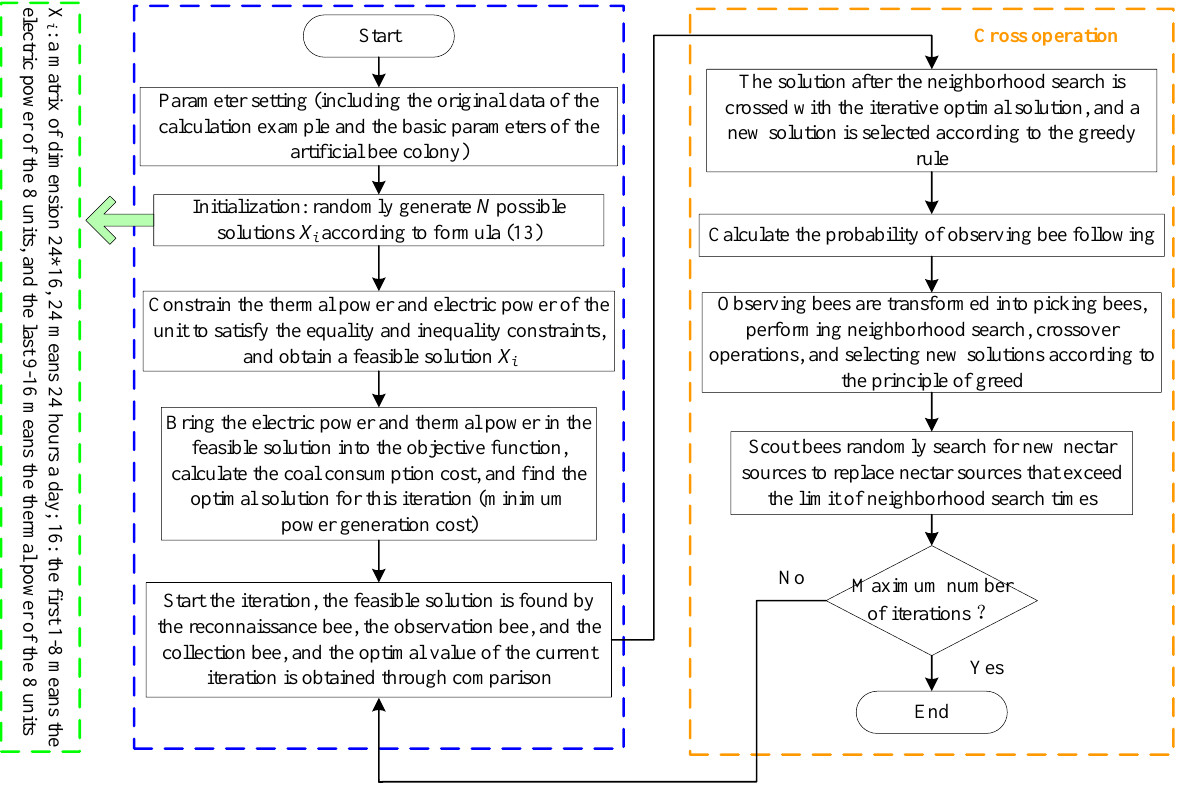
Figure 12. Flowchart of the solving algorithm.